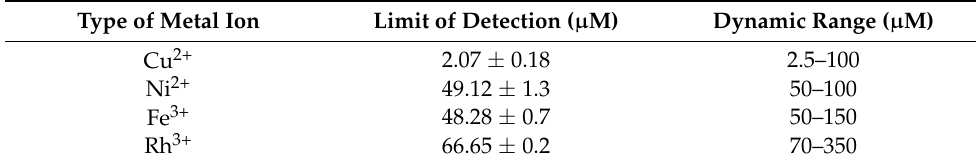
Table 1. Calculated LOD and dynamic range values of Cu 2+ , Ni 2+ , Fe 3+ and Rh 3+ ions. Type of Metal Ion Limit of Detection ( µ